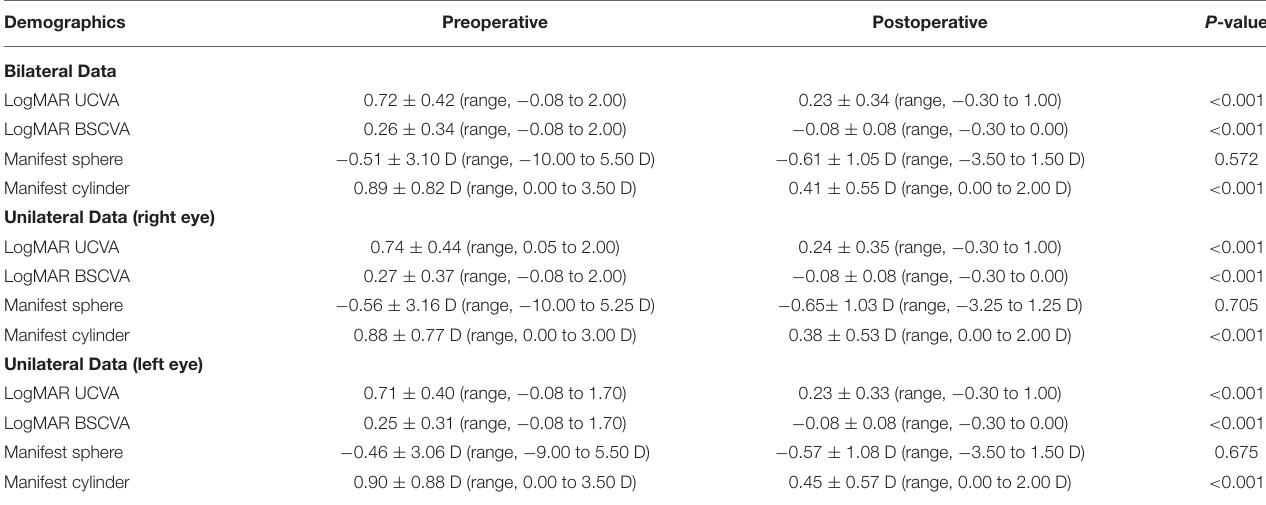
TABLE 2 | Visual and refractive outcomes of the study population undergoing standard cataract surgery through a 2.8mm temporal clear corneal incision.